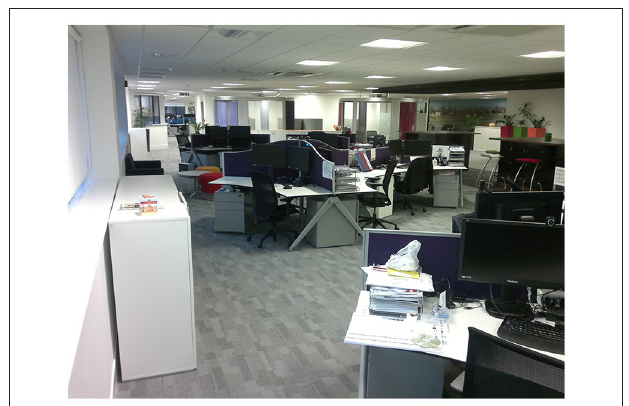
FIGURE 4 | A photograph of the open-plan office. The photo was taken from the right-hand bottom corner of Figure 3